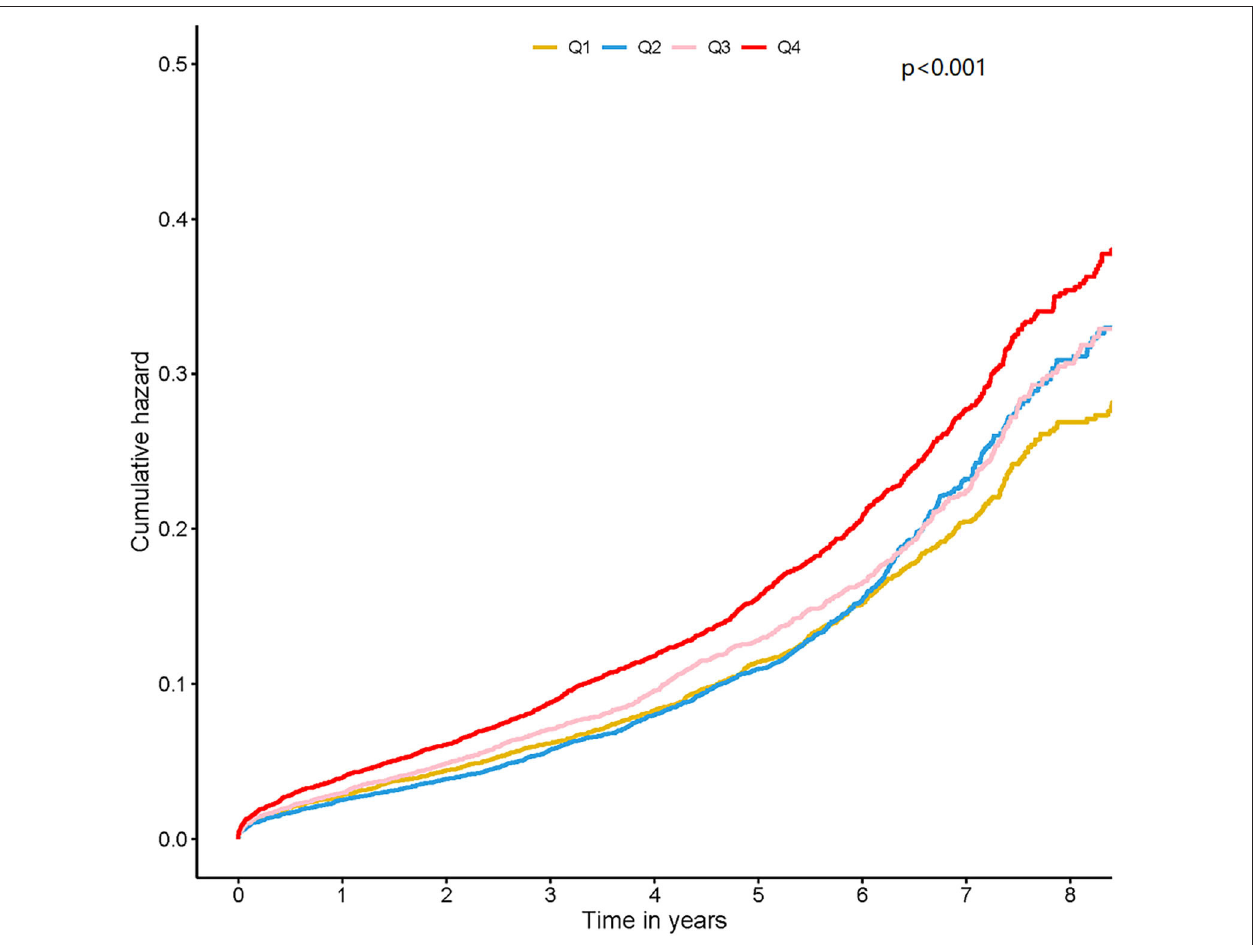
FIGURE 1 | Kaplan-Meier curves for quartile values of plasma levels of HbA1c. Quartile 1: HbA1c ≤ 5.7; Quartile 2: 5.7 < HbA1c ≤ 6.1; Quartile 3: 6.1 < HbA1c ≤ 6.7; Quartile 4: HbA1c > 6.7.